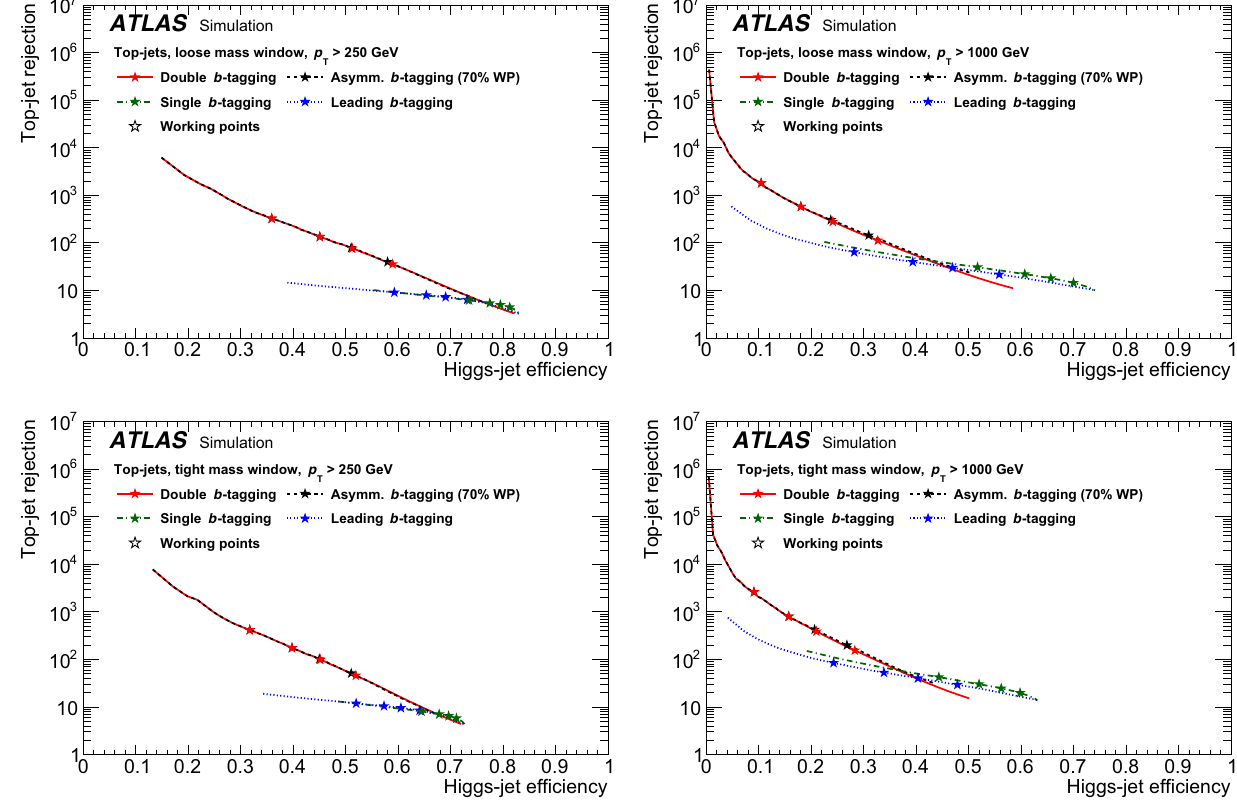
Fig. 10 Rejection of the top-jet background as a function of the Higgs tagging efficiency for loose (top) and tight (bottom) mass win- dow requirements for large- R jet p T above 250 GeV (left) and above 1000 GeV (right) for various b -tagging benchmarks. The stars corre-